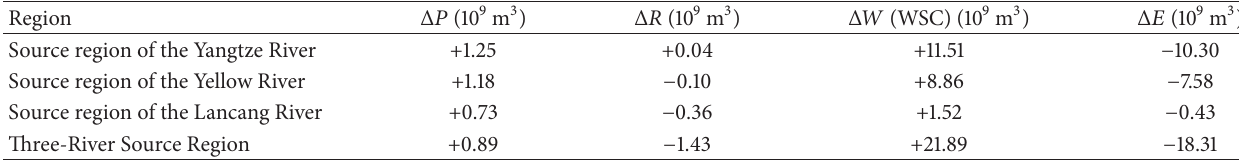
Table 6: Changes of volume in subregion of Three-River Source